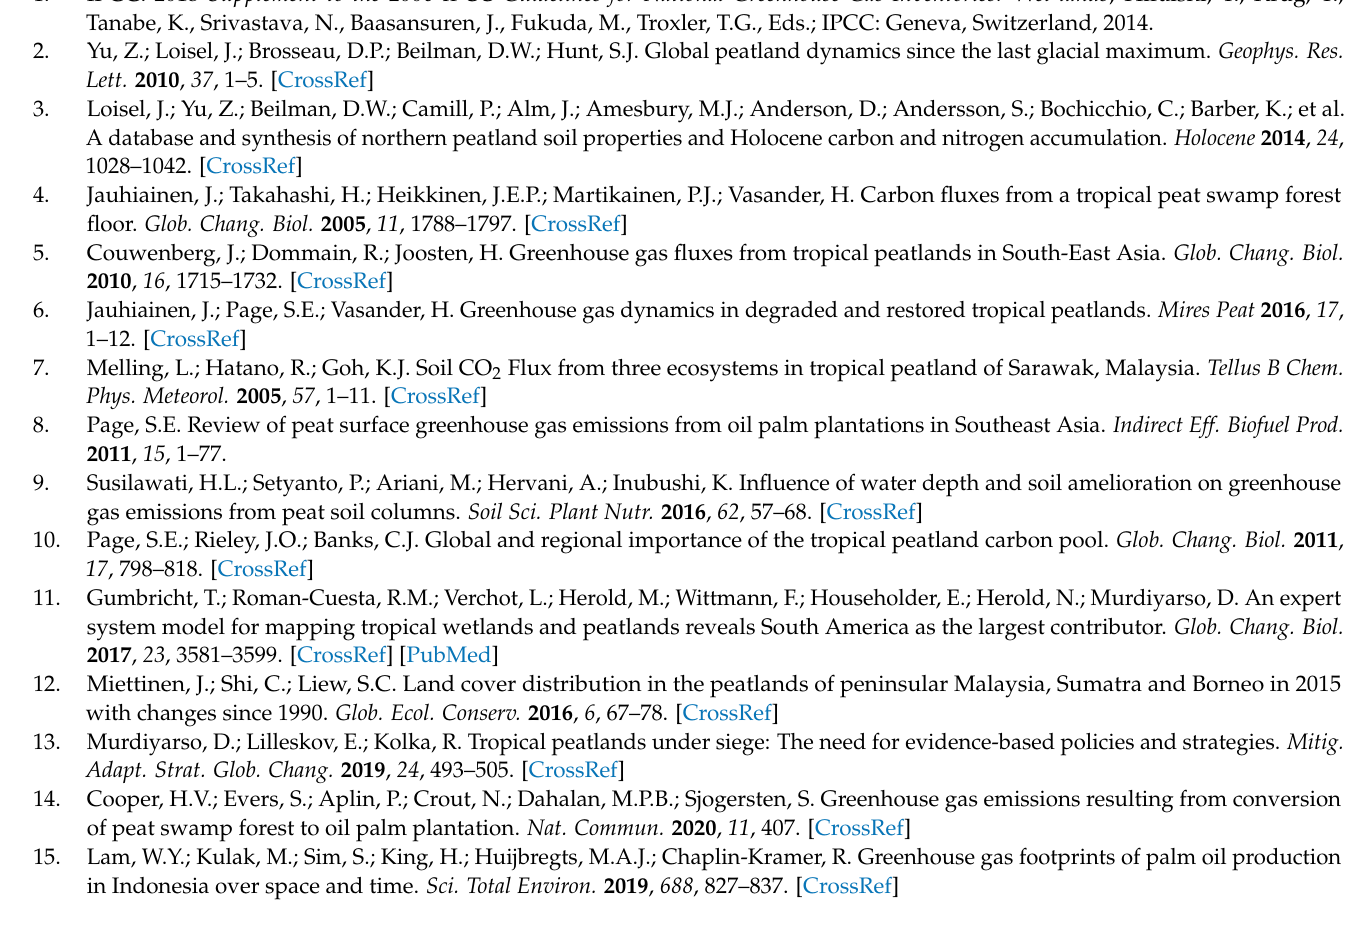
Table S1: GHGs emission of drained-agricultural in tropical peatlands, tropical mineral and northern peatland by closed chamber and estimation from subsidence measurement, Table S2: GHGs’ emis- sions of managed, recovery-rewetting, secondary-drained forest systems in tropical and northern peatlands by closed chamber and estimation from subsidence measurement, Table S3: GHGs emission of natural forest system in tropical and northern peatlands by closed chamber and estimation from subsidence